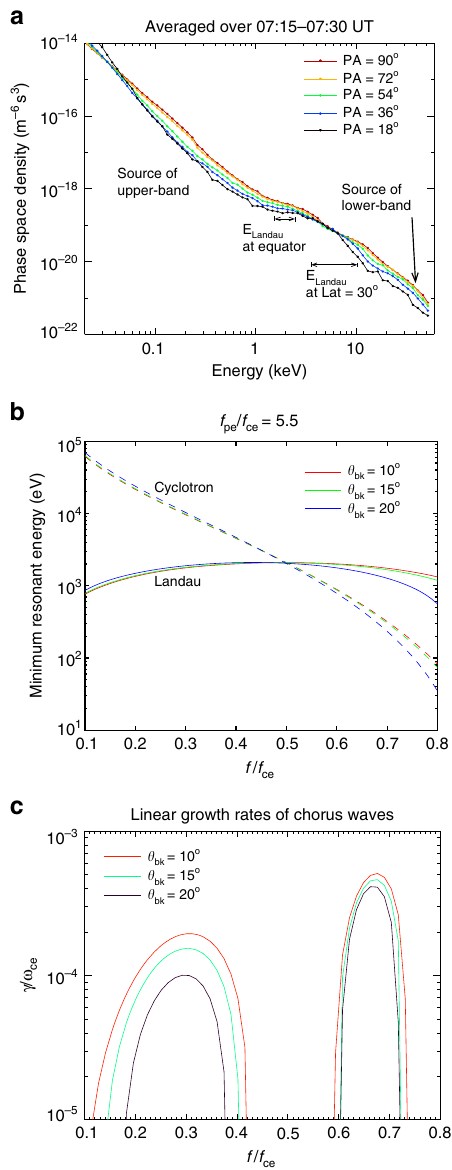
Fig. 2 Electron PSD measurements, resonant energy analysis and linear growth calculations. a 15-minute-averaged electron PSD versus energy measured by the HOPE spectrometer onboard the Van Allen